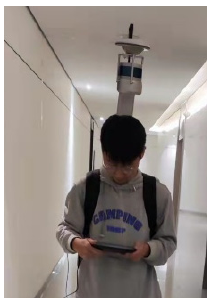
Figure 6. Backpack collection